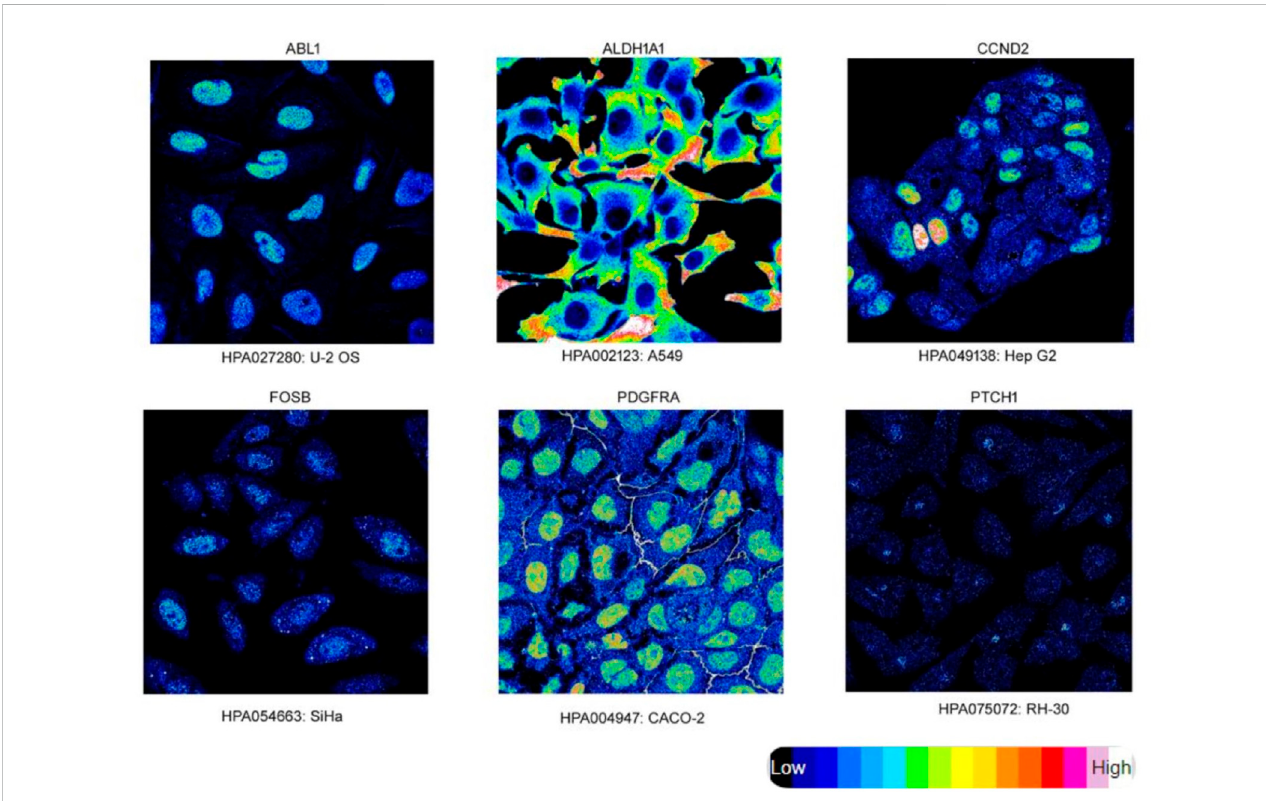
FIGURE 7 Immuno fl uorescence Staining. Localization and expression of hub genes in endometrial tissue. Endometrial Cancer hub genes (target gene) expression (intensity) in various cell lines, subcellular staining represents target proteins with intensity using different